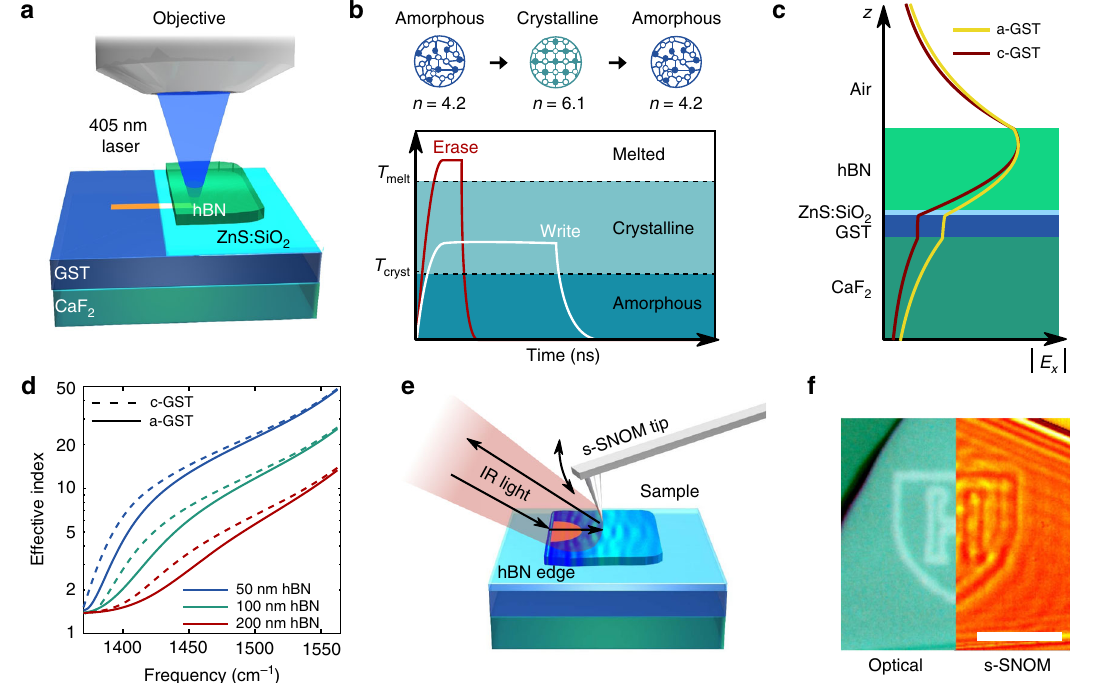
Fig. 1 Recon fi gurable polaritons in hBN-GST heterostructures. a Writing setup and device cross-section. A 405 nm focused laser beam is used to write and recon fi gure devices on GST underneath hBN (transparent at 405 nm). b Longer, low-power laser pulses are used to crystallise GST and shorter high-power pulses are used to melt it to restore the amorphous phase. c Electric fi eld pro fi le of polaritons for the a-GST and c-GST cases. The electric fi eld con fi nement is larger in c-GST (due to its larger refractive index) than in a-GST. E x represents the electric fi eld along the direction of polariton propagation. Thicknesses for each layer are 195 nm for hBN, 15 nm for ZnS:SiO 2 , 55 nm for GST and 1 mm for CaF 2 , which is then considered semi-in fi nite. Refractive indices are 1.7 for ZnS:SiO 2 , 4.2 and 6.1 for GST in amorphous and crystalline phases, respectively, 1.37 for CaF 2 , while hBN is modelled with the Lorentz model